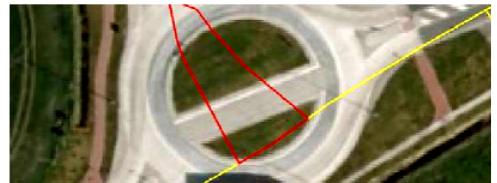
Figure 6: Redeveloped roundabout identified by grassland detection (revised roads = red, no decision = yellow)